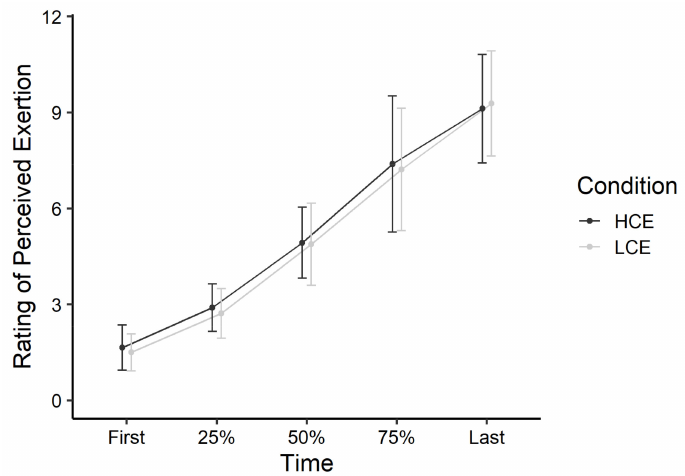
Figure 4. Iso-time ratings of perceived exertion during the physical task, by condition. Data points represent means with standard deviation error bars. LCE = low cognitive exertion; HCE = high cognitive exertion.